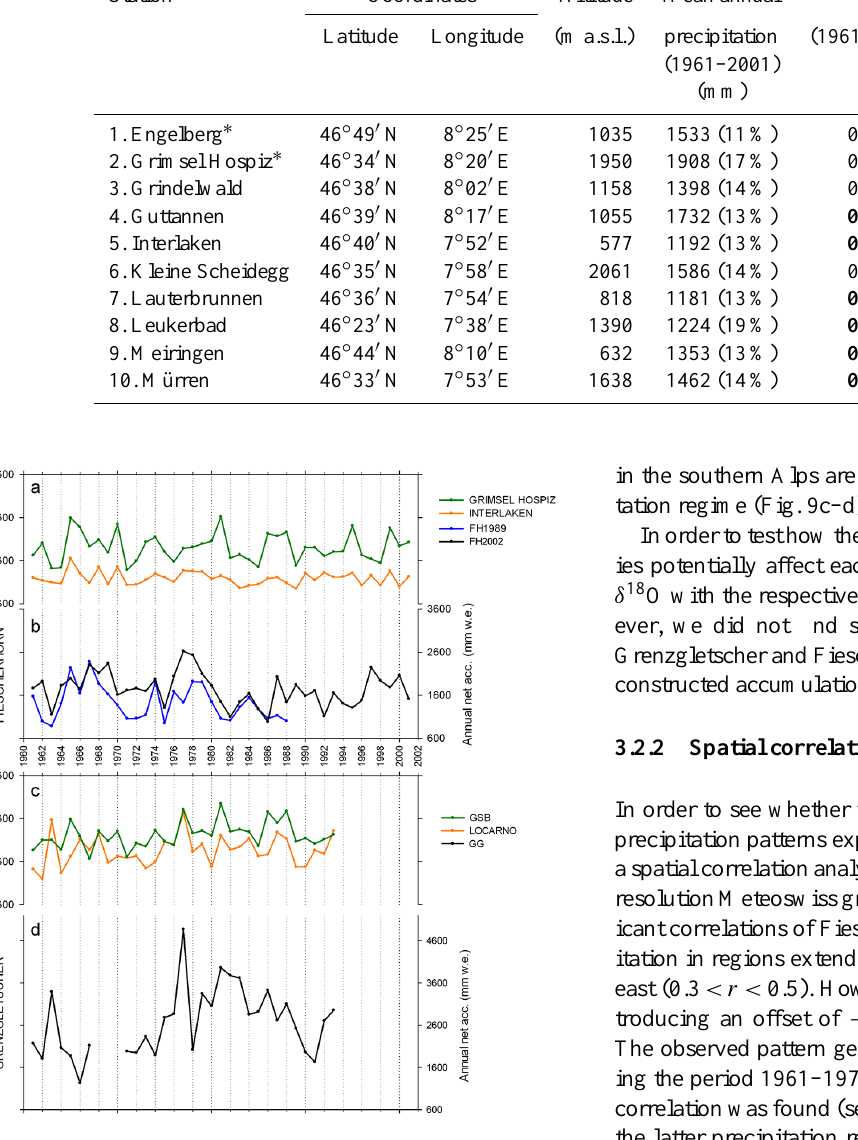
Figure 9. (a) Annual sum of precipitation from the high- and low- altitude stations Grimsel Hospiz (1950ma.s.l., green) and Inter- laken (577ma.s.l., orange). (b) Reconstructed annual accumula- tion at the Fiescherhorn glacier for FH2002 (black) and FH1989 (blue). (c) Annual sum of precipitation from the high- and low- altitude stations Grand Saint Bernard (2472ma.s.l., green) and Lo- carno (367ma.s.l., orange). (d) Reconstructed annual accumulation at the Grenzgletscher (black). Note that the panels are shown on the same scale, to allow a direct comparison of the